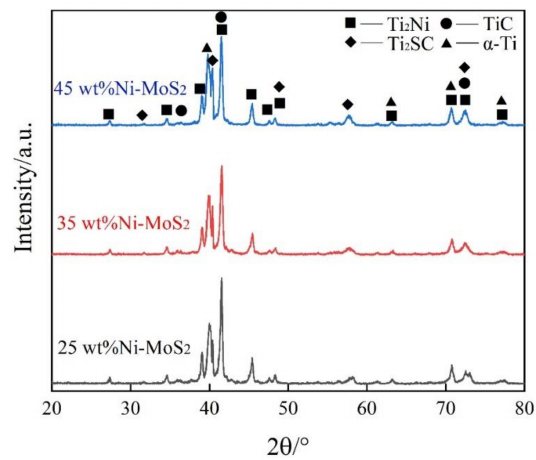
Figure 5. The XRD diffraction pattern of the